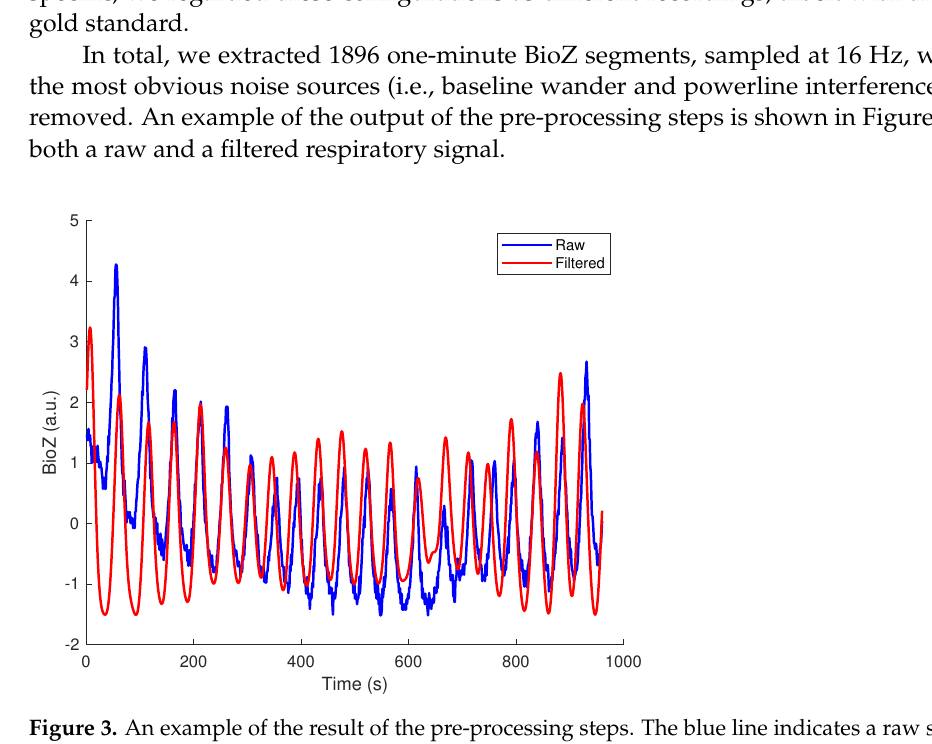
Figure 3. An example of the result of the pre-processing steps. The blue line indicates a raw signal of one-minute and the red line indicates the filtered version. The baseline wander and high frequency noise are mostly